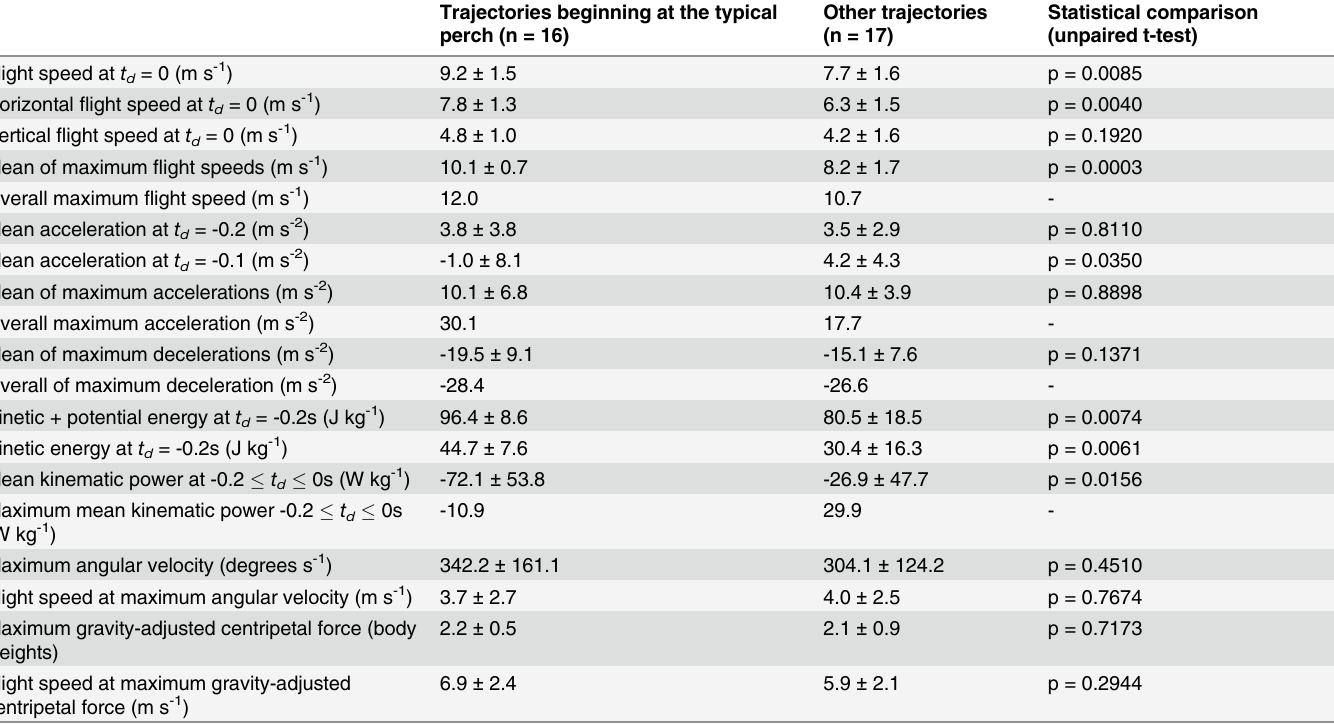
Table 2. Defending bird trajectories.